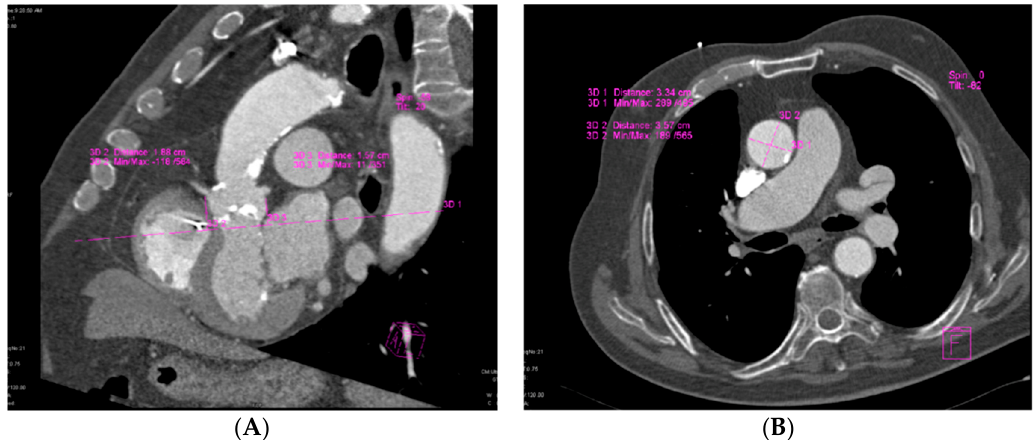
Figure 1. Assessment of aortic annular plane via MDCT: ( A ) Aortoventricular centerline; ( B ) Manual measurements of aortic annulus diameter.